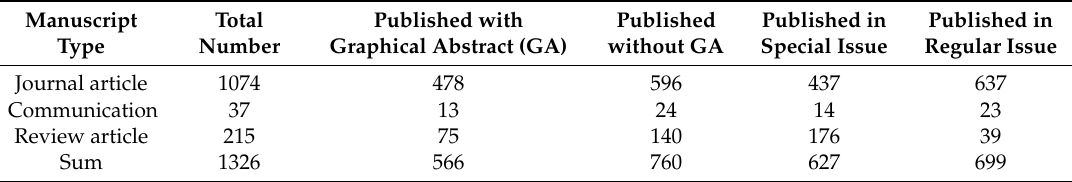
Table 1. Structure of the evaluated dataset.